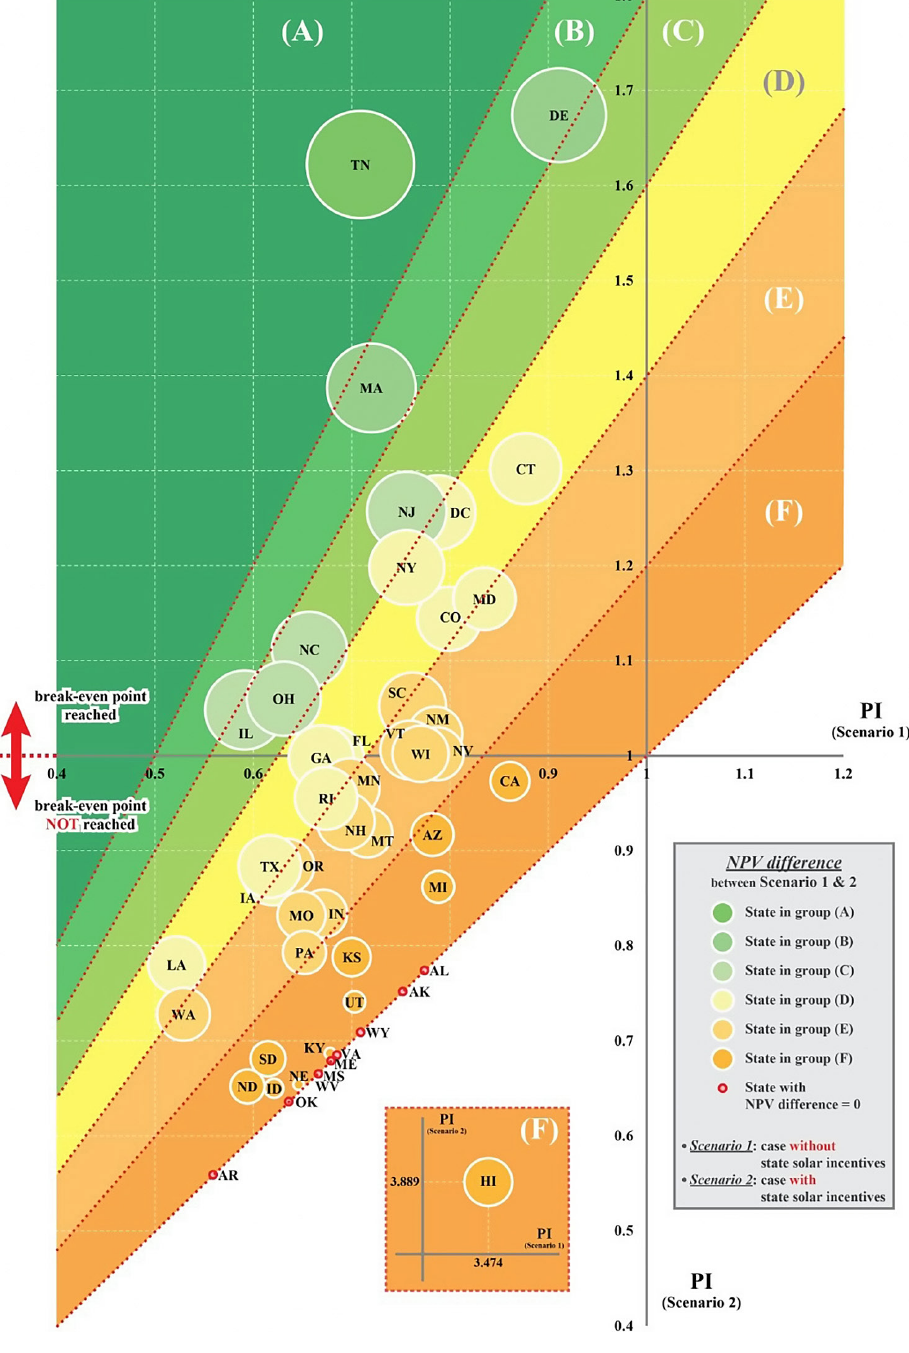
Fig. 4. Impact analysis of solar state